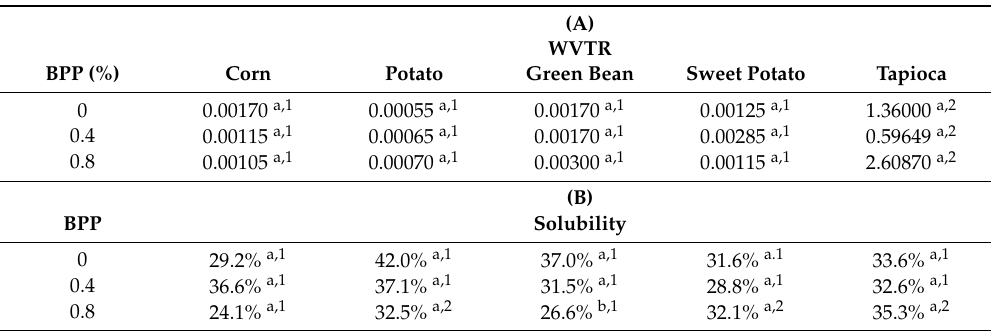
Figure 3. The tensile strength of films made from di ff erent types of starch and BPP levels. Data points represent the means ± standard deviations of six replicates (unit: g). Table 4. (A). The water vapor transmission rate (WVTR) (A) of films made from di ff erent types of − 1 ) starch with di ff erent starch and BPP levels (unit : g · cm − 2 · h , (B). The solubility of films made from di ff erent types of starch with di ff erent starch and BPP levels